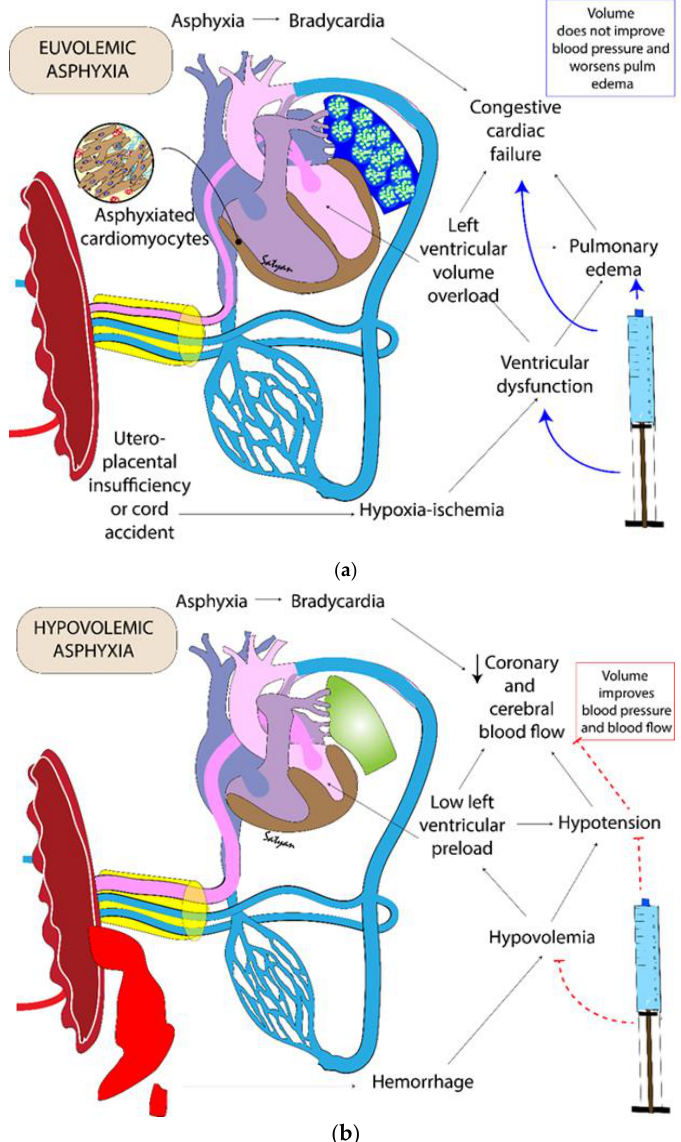
Figure 2. Illustration of euvolemic asphyxia ( a ) and hypovolemic asphyxia ( b ) and potential conse- quences of volume replacement during resuscitation. Copyright Satyan